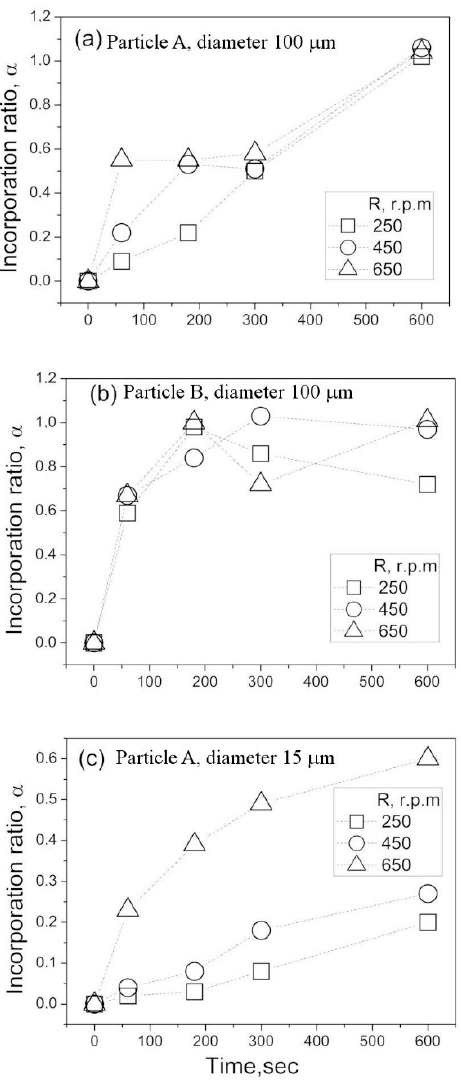
Figure 4. Time variation of particle incorporation ratio. ( a ) Particle A, diameter 100 μ m, ( b ) Particle B, diameter 100 μ m, ( c ) Particle A, diameter 15 μ m,